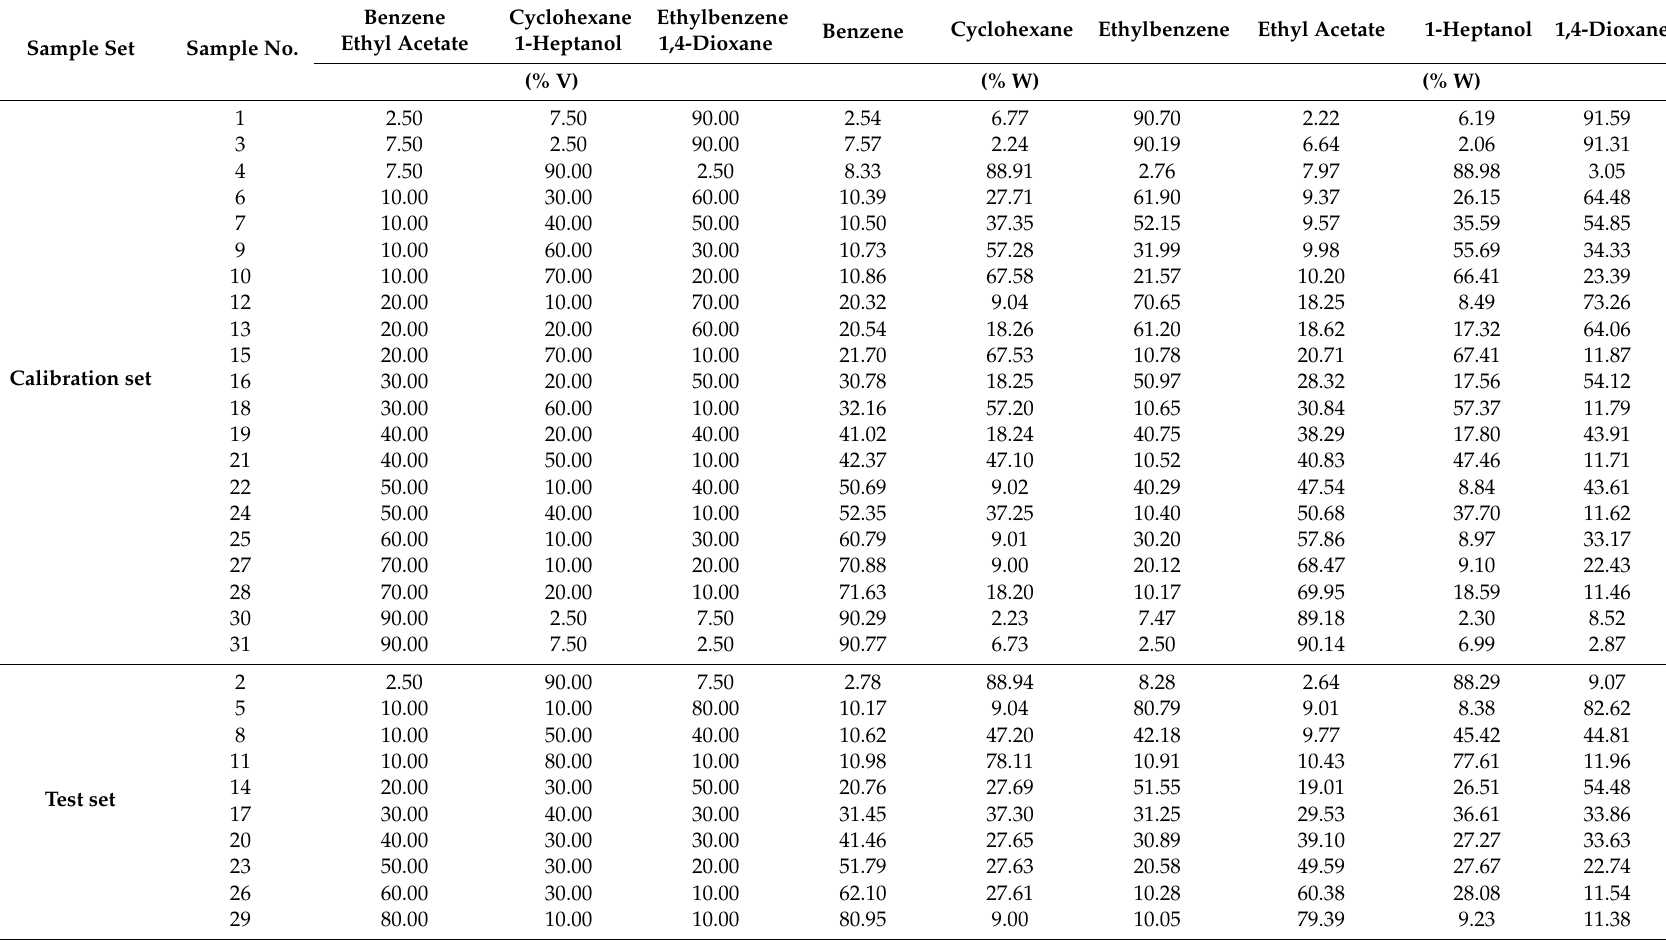
Table 3. Volume and weight percentage (%V and %W) compositions of the calibration and test samples (total volume 30 mL) of the two mixture systems.